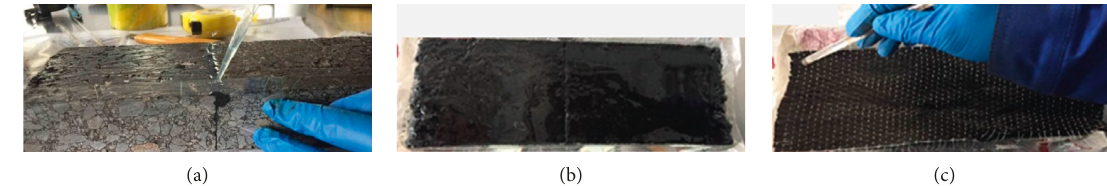
Figure 8: Preparation process of the test plate for the fatigue test. (a) Bonding using the high-toughness resin. (b) Smearing the high- toughness resin. (c) Laying CF cloth.